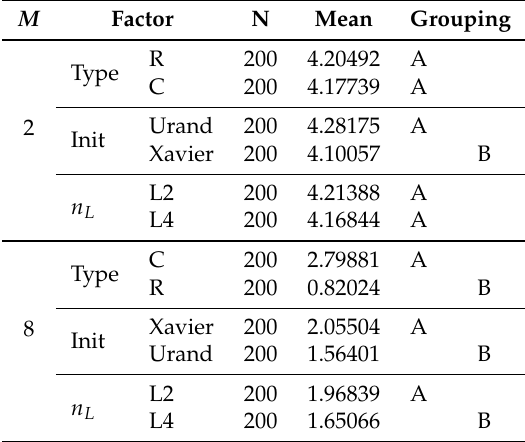
Table 3. Tukey pairwise comparison for h = sigmoid and single factors]Tukey pairwise comparison 3-way ANOVA for h = sigmoid and single factors. Grouping information using the Tukey test and 95% confidence. Means that do not share a letter are significantly different